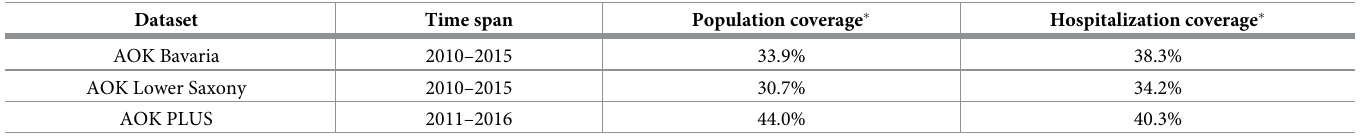
Table 1. Description of health insurance